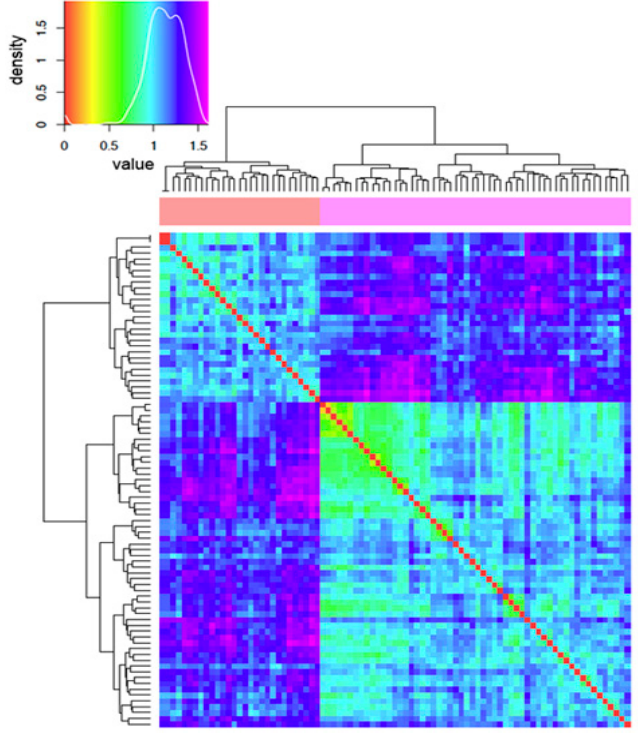
Figure 2. Clustering of Baeyer–Villiger monooxygenases (BVMOs) according to their electrostatic